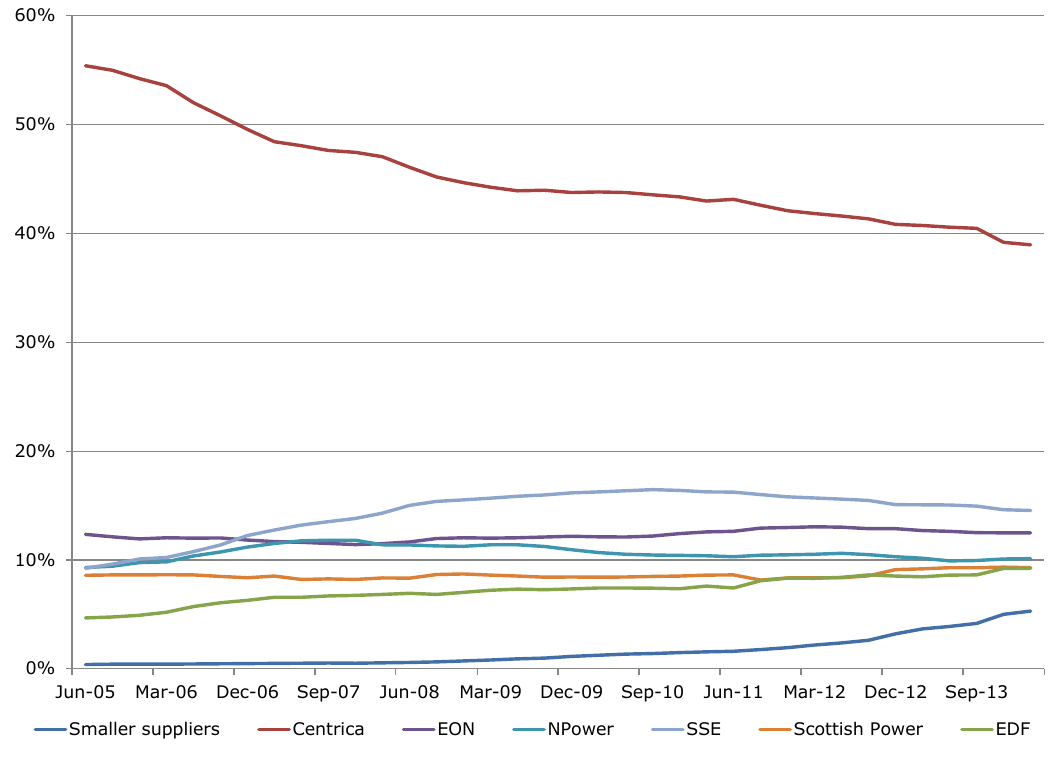
Figure 4: Domestic gas supply market